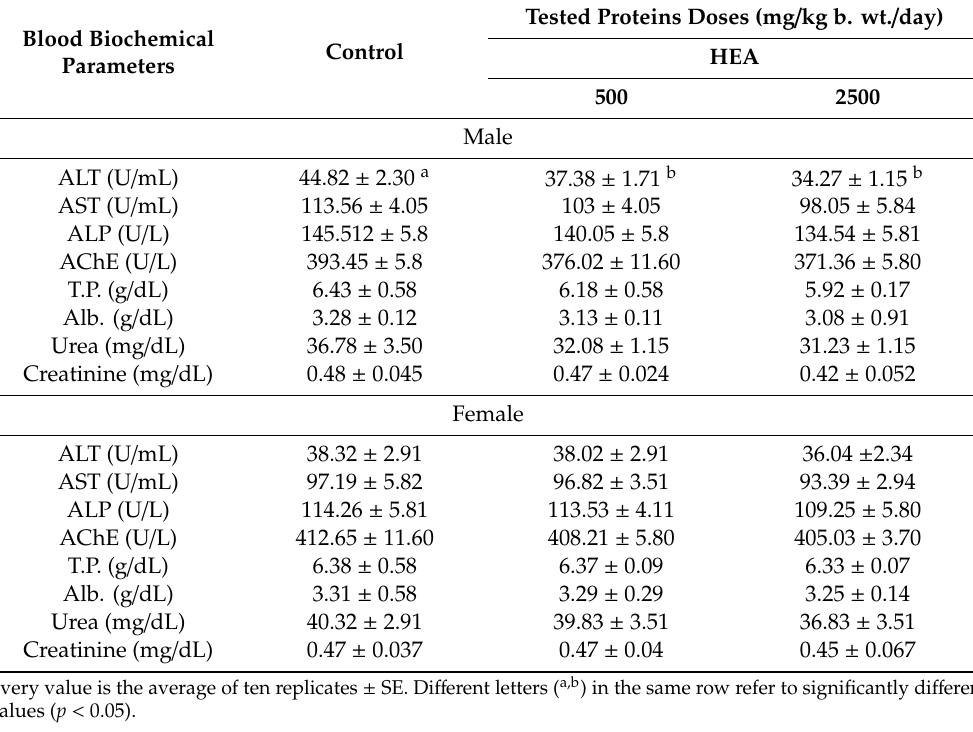
Figure 7. Histopathological examination of H&E stained sections of liver of male and female albino rats administered 2500 mg/kg body weight of HEA as compared to control (0 mg/kg body weight) using 1200× magnification power. 3. Discussion The occurrence and spread of antibiotic resistant bacteria are pressing public health problems worldwide [13,34,42]. Many bacteria have become resistant against many antimicrobial agents. The